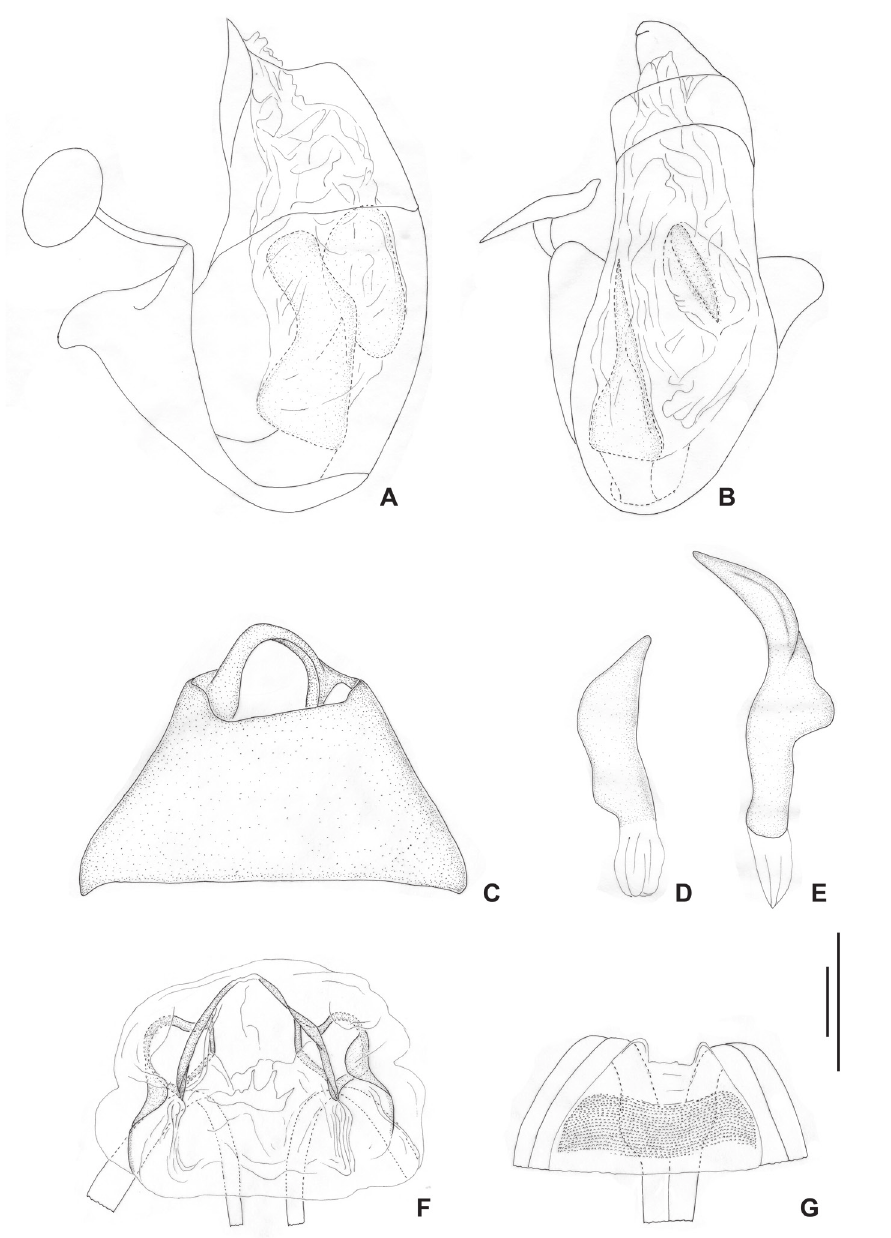
Fig. 10. Genitalia of C. weiri sp. nov. A . Aedeagus, left lateral view. B . Aedeagus, ventral view. C . Genital capsule. D . Right paramere. E . Left paramere. F . Dorsal labiate plate of bursa copulatrix. G . Posterior wall of bursa copulatrix. Scale bars = 0.1 mm (the large scale bar is for A–B and D–E, the small scale bar is for C